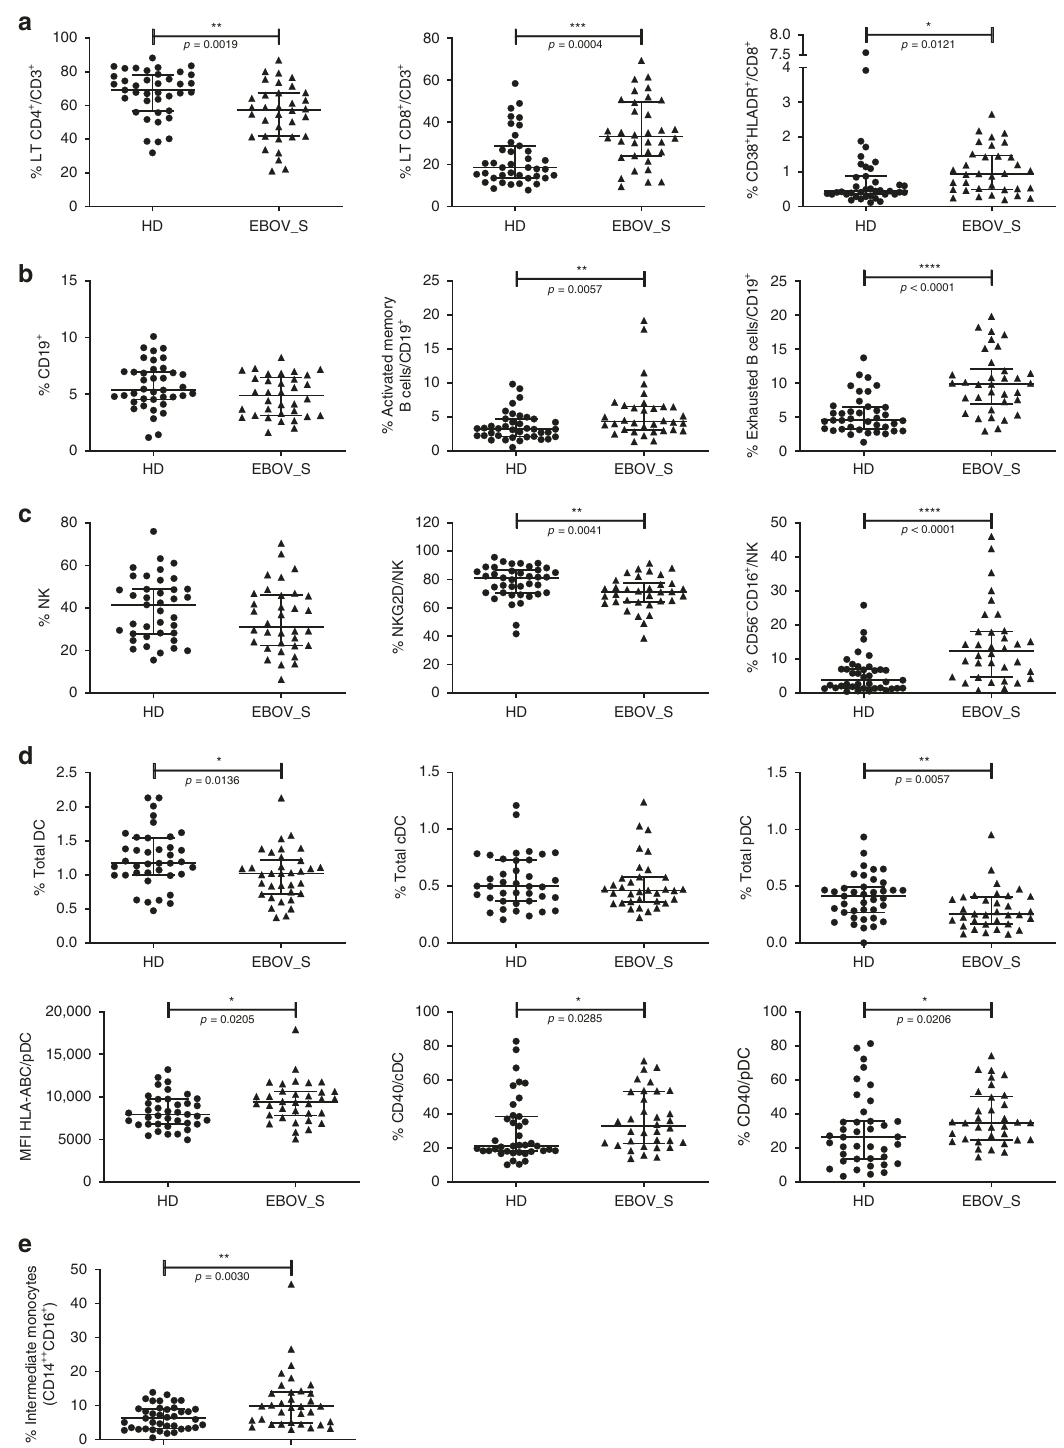
Fig. 2 Modi fi cations in immune cell subset frequencies in EBOV_S. Cumulative T cell frequency and CD8 T cell activation analyses ( a ), B cell subsets ( b ), NK cell subsets ( c ), dendritic cell subsets and activation ( d ), and monocyte subsets ( e ) from n = 34 EBOV_S and n = 39 HDs. DC gating strategy is shown in Supplementary Fig. 4. The differences between HDs and EBOV_S were evaluated with nonparametric Mann – Whitney U tests. Median values± IQR are shown. Source data are provided as a Source Data fi